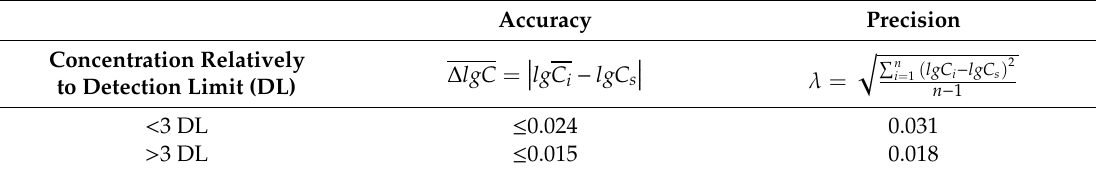
Table 1. References for accuracy and precision of obtained